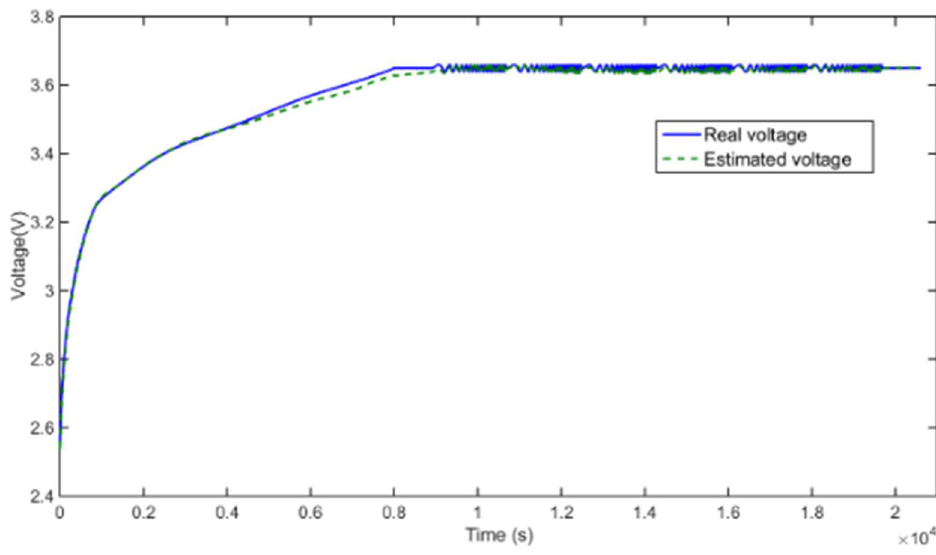
Figure 23. Comparison of real and estimated voltage of test 3 under dynamic condition.